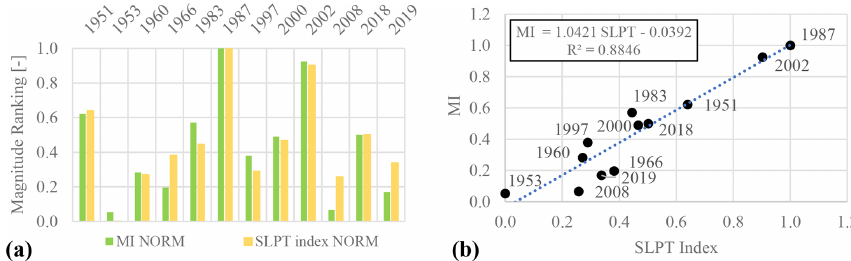
Figure 10. Comparison between the MI and SLPT index, normalized. The events recorded in 1951, 1987, 2002, and 2018 have the highest magnitude, while the 1953 and 2008 events have the lowest